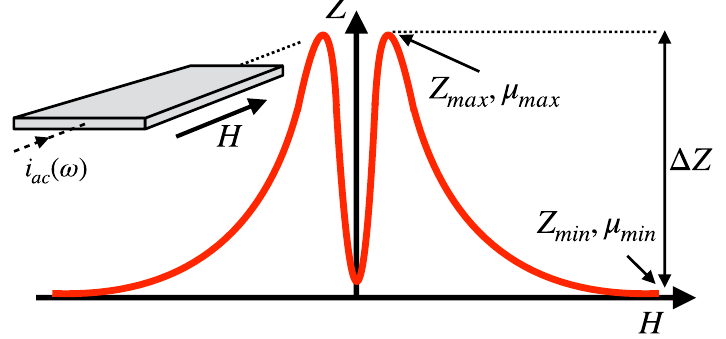
Figure 1. Sketch of the dependence of the impedance on the applied magnetic field in a soft magnetic sample with transverse anisotropy (in-plane easy axis, perpendicular to the current flow and the applied field).